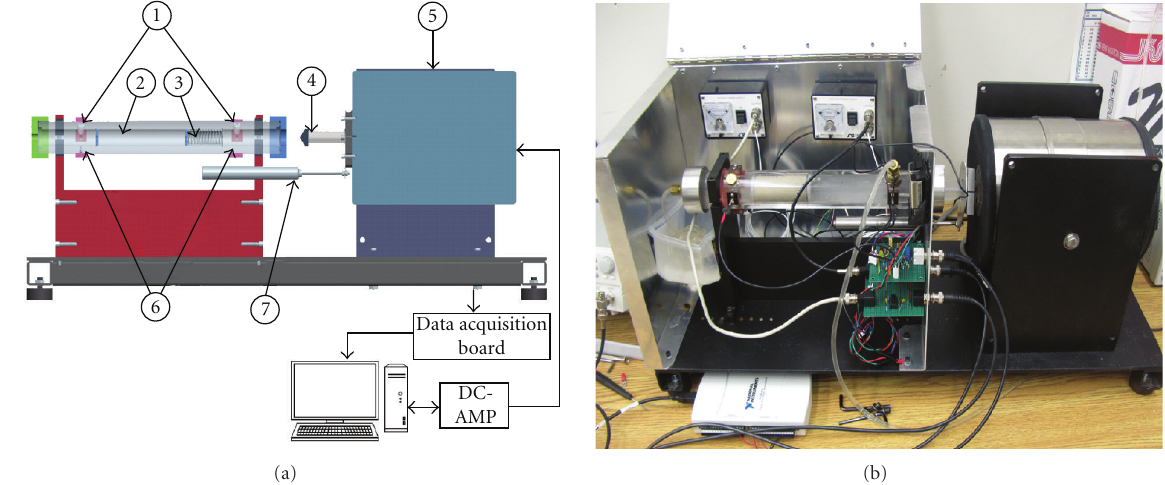
Figure 4: The electromagnetic drive apparatus for measuring the time-dependent streaming potential coe ffi cient of granular media; (a) diagram, (b) photograph. (1) Port for fluid circulation or pressure transducer (2 at each end), (2) space for sample, (3) support spring and perforated end-piece, (4) piston, (5) precision electromagnetic shaker, (6) position of electrodes, and (7) linear motion sensor (LVDT).